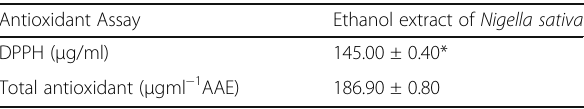
Table 6 In vitro antioxidant activities of the ethanol extract of Nigella